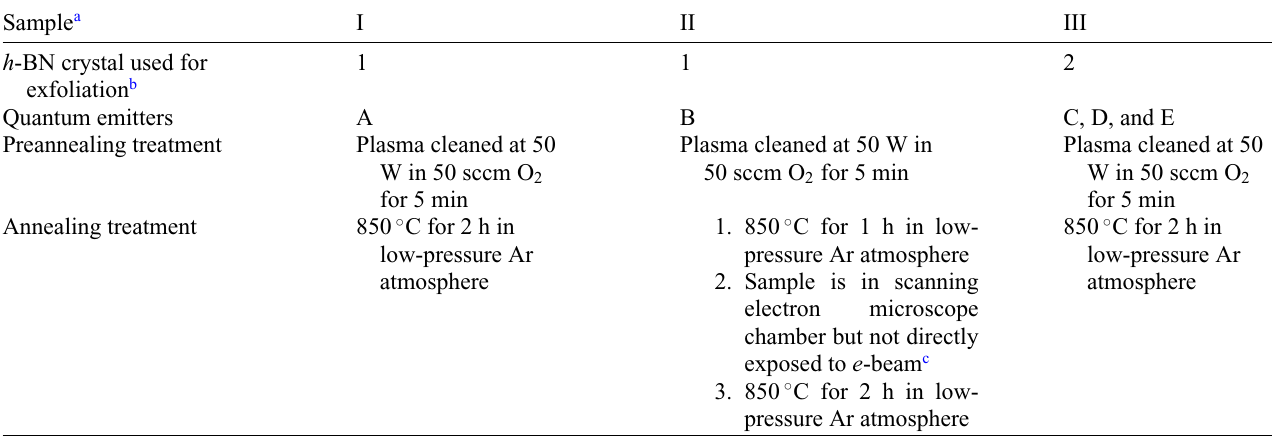
TABLE I. The samples, quantum emitters and sample